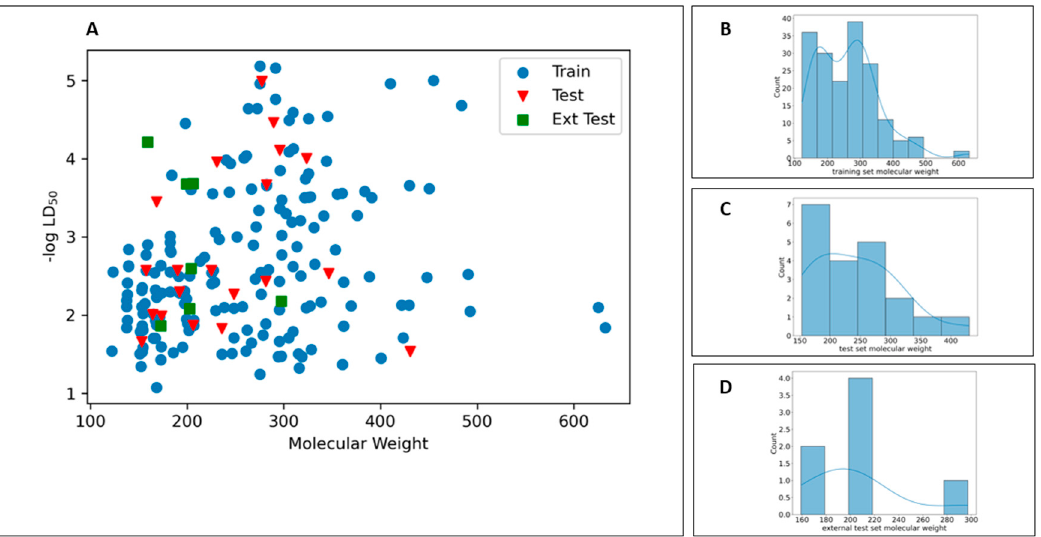
Figure 2. ( A ) Scatter plots of − logLD 50 values vs. molecular weight. Histogram of molecular weights for ( B ) training set, ( C ) test set, ( D ) external test set.